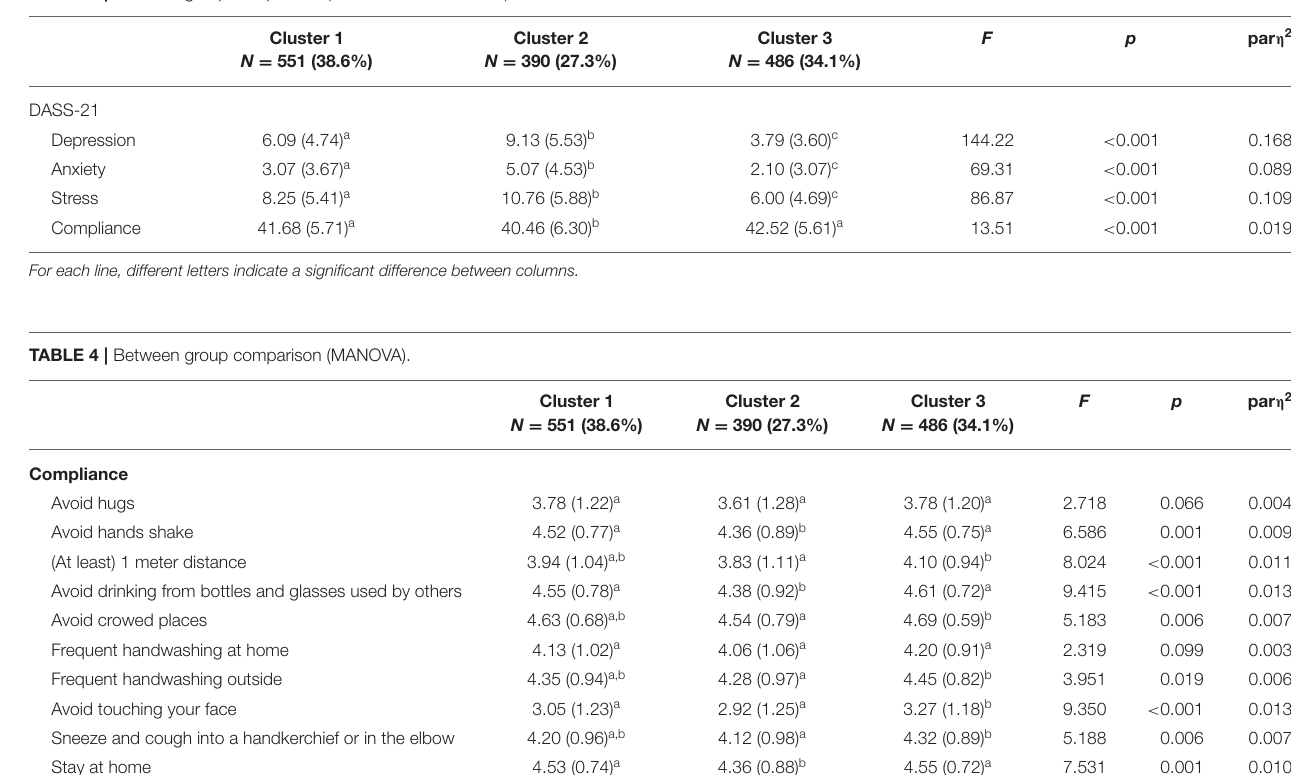
TABLE 3 | Between group comparison (MANOVA and ANOVAs).